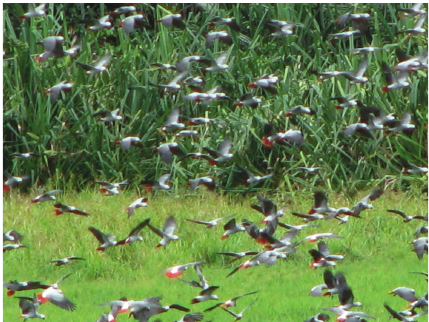
Figure 3: Grey Parrots congregate at a feeding site in a swampy area in the rainforest of Southeastern